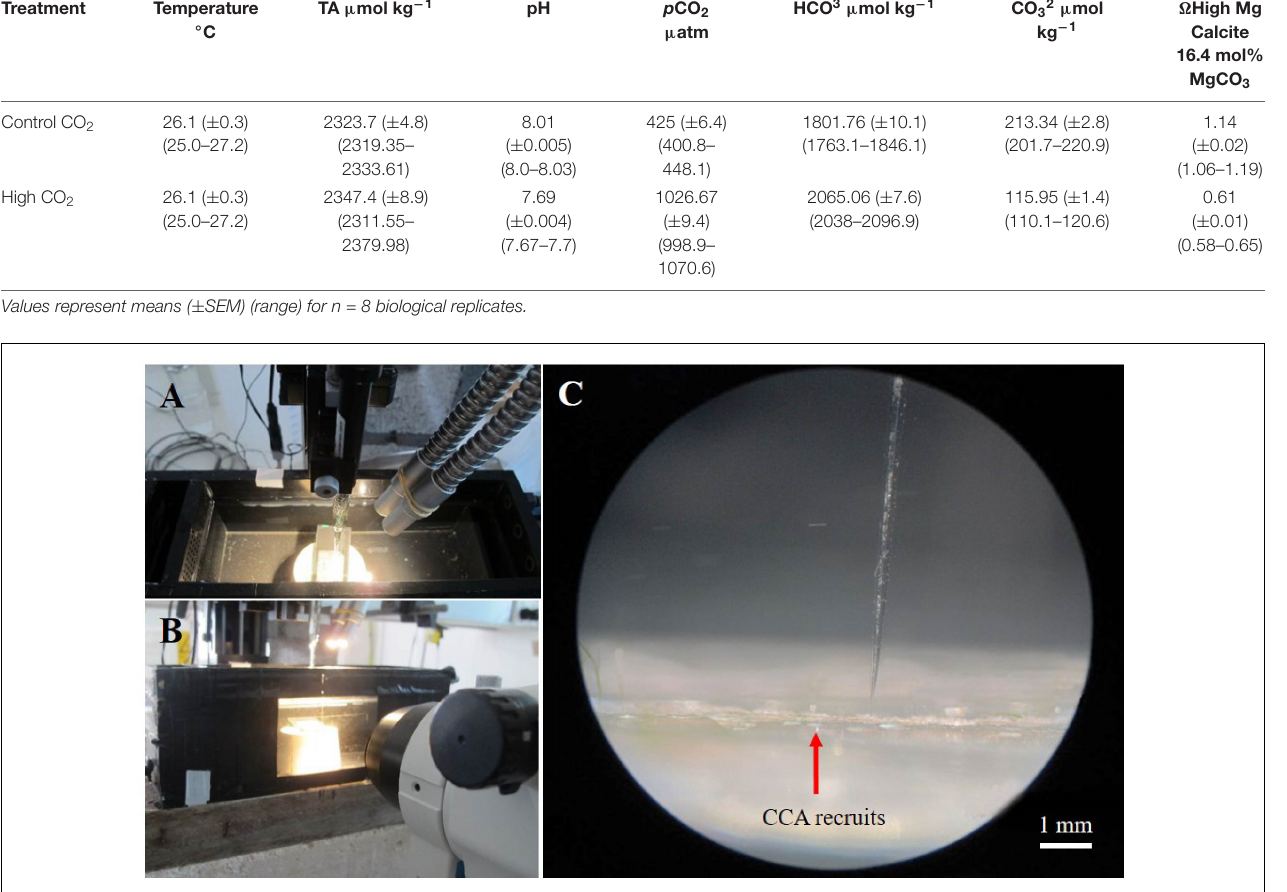
TABLE 1 | Summary of water chemistry parameters for the different CO 2 levels. Treatment